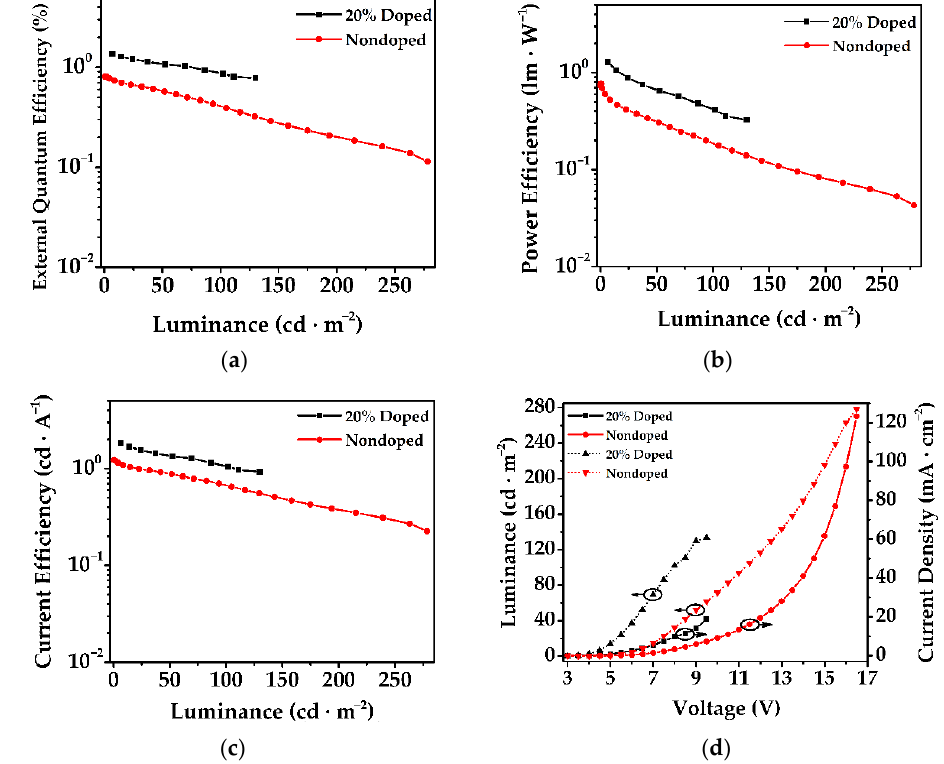
Figure 6. ( a – c ) The EQE, PE, and CE versus luminance plots, and ( d ) current density–luminance– voltage (J–L–V) plots for nondoped and doped devices. Circles and arrows in ( d ) indicated which side of the y axis the curve followed.